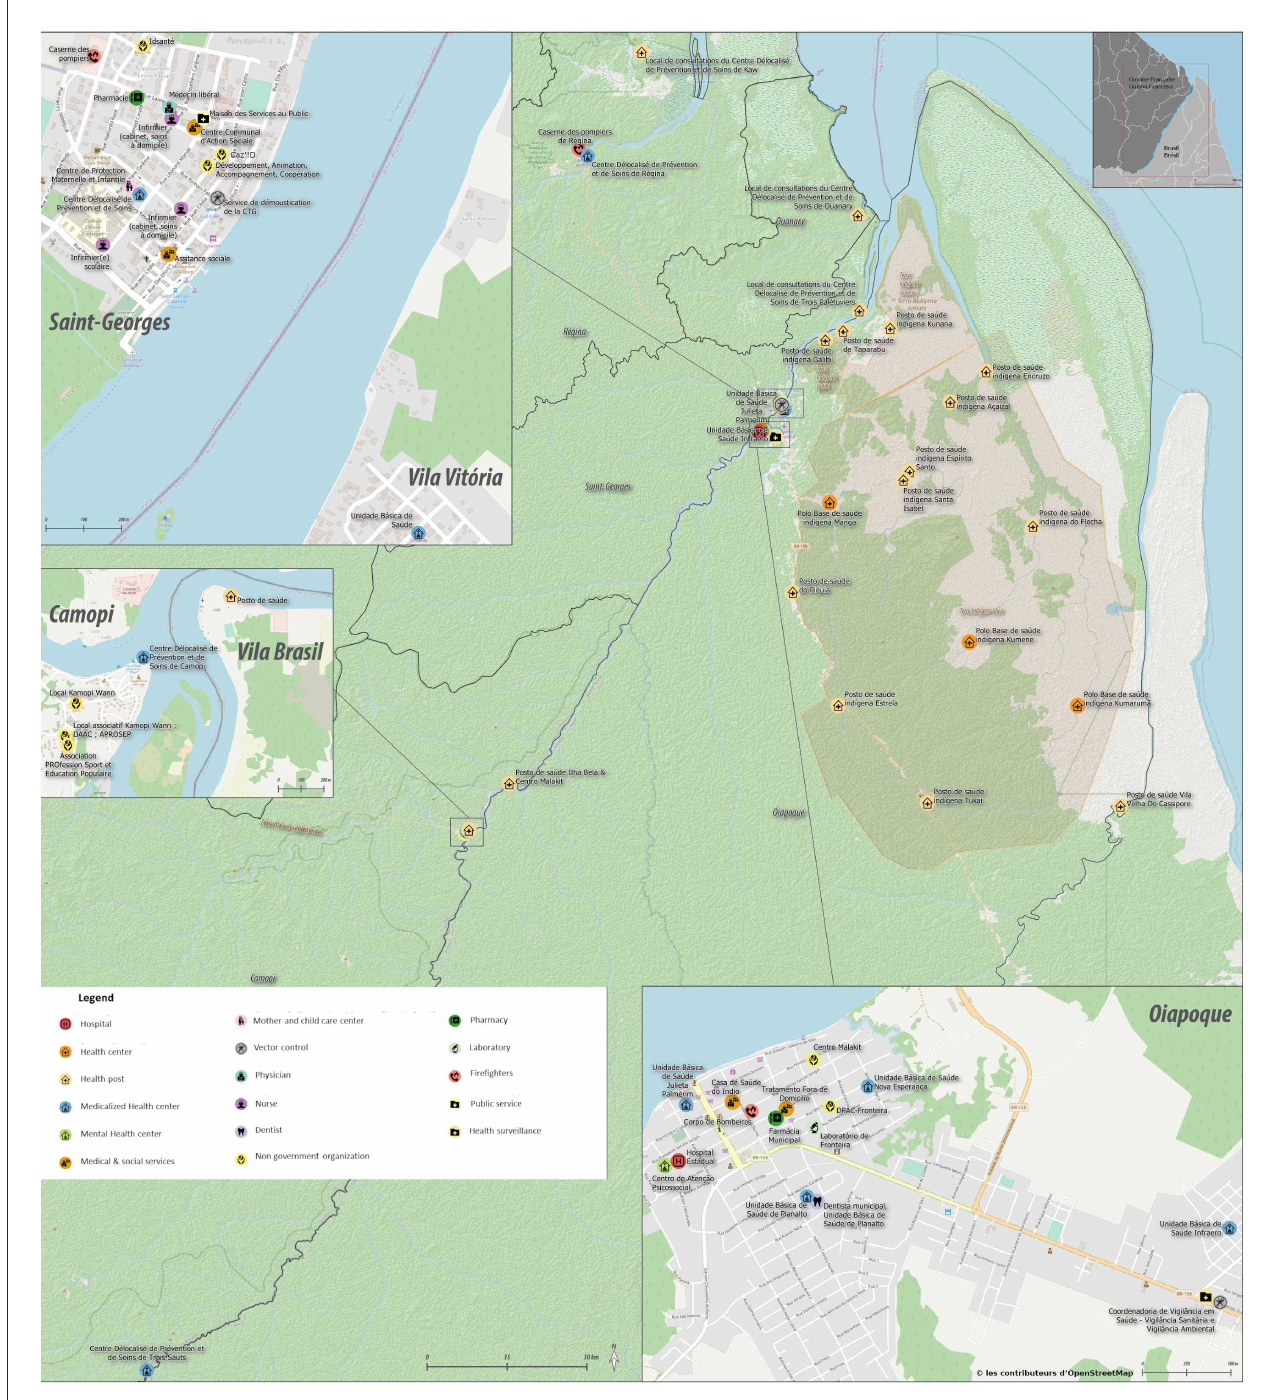
FIGURE1 Map of the main border towns on the Oiapoque river between French Guiana and